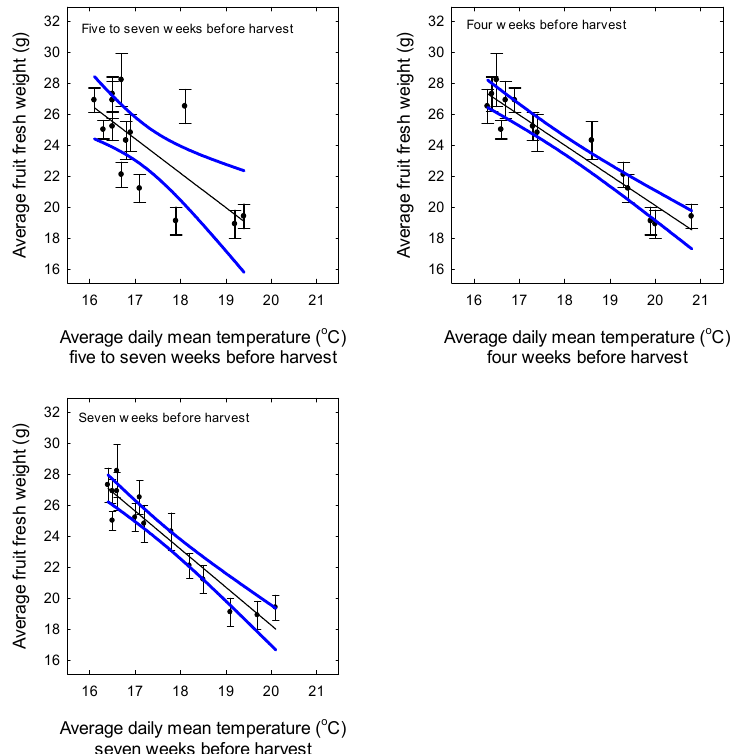
Figure 3. Relationship between average fruit fresh weight (marketable fruit weighing at least 12 g) (AFWT) and average daily mean temperature (Temperature) during different periods before harvest from 29 July to 28 October in strawberries in Queensland. These periods covered flower development (five to seven weeks before harvest), fruit development (four weeks before harvest), and flower and fruit development (seven weeks before harvest). Data are the means ( ± SE or standard error) of five cultivars with six replicates for each cultivar. AFWT (g) = Intercept—2.22 × Temperature Weeks5-7 ( p < 0.001, R 2 = 0.48, n = 14). AFWT (g) = Intercept—1.95 × Temperature Weeks4 ( p < 0.001, R 2 = 0.90, n = 14). AFWT (g) = Intercept—2.45 × Temperature Weeks7 ( p < 0.001, R 2 = 0.90, n = 14). Blue lines indicate 95% confidence